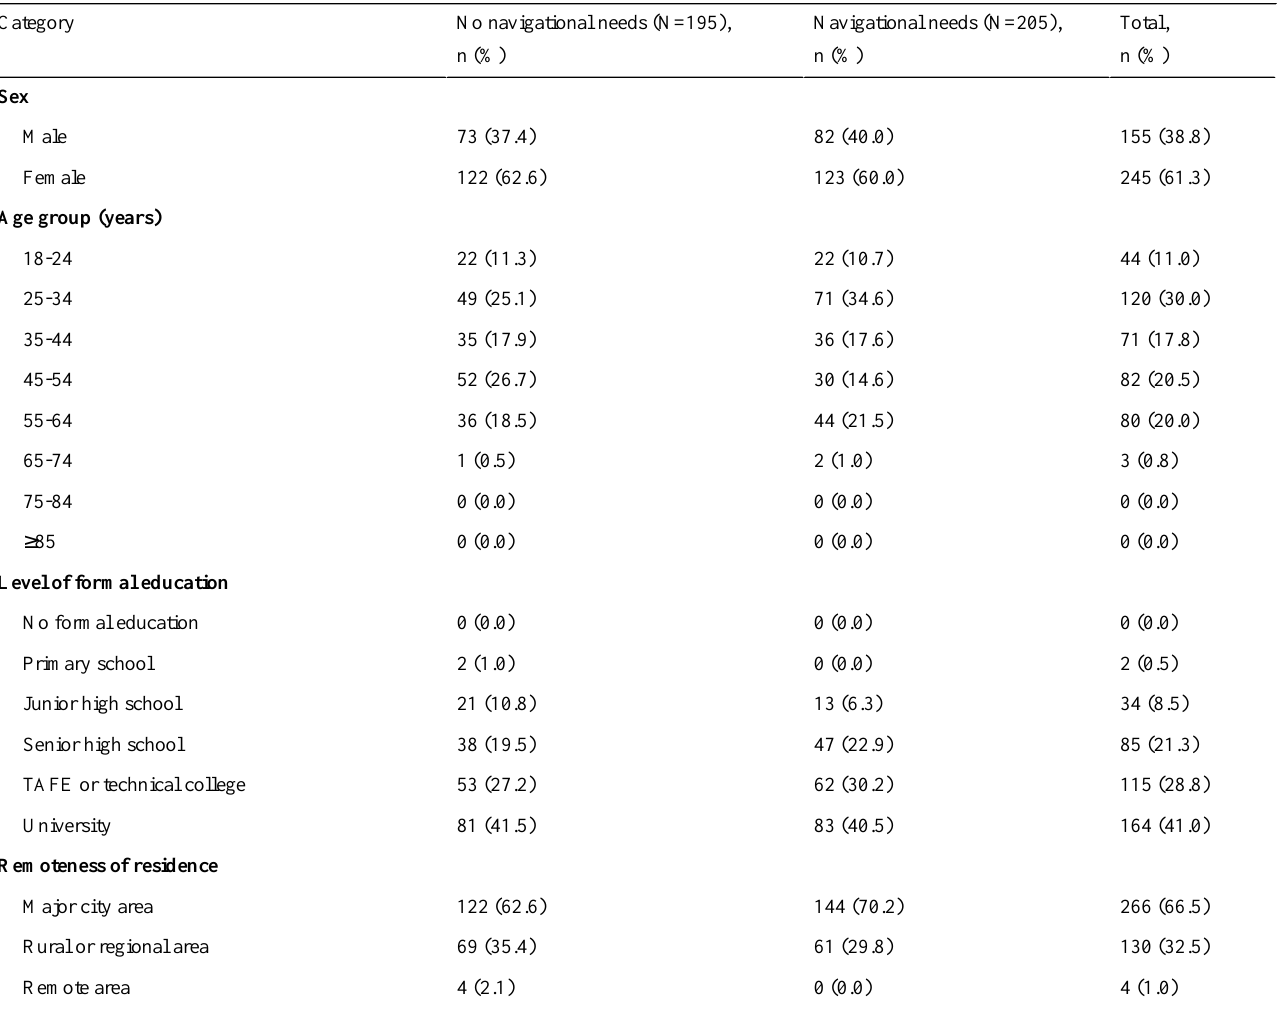
Table 1. Demographic descriptors of respondents (N=400).